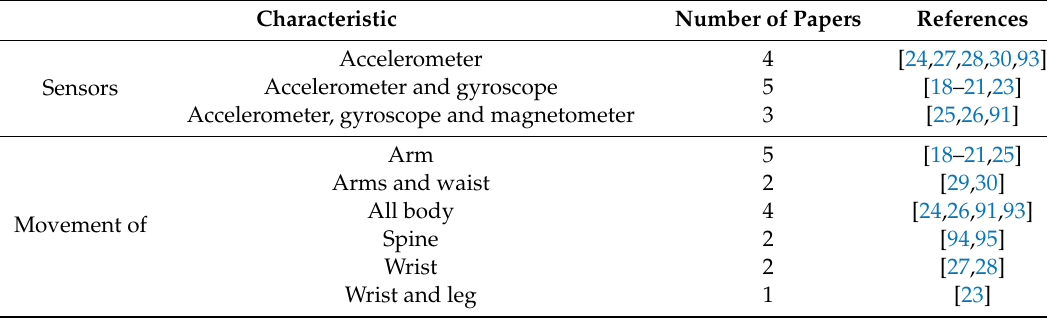
Table 1. Sensor-based studies conducted for activity